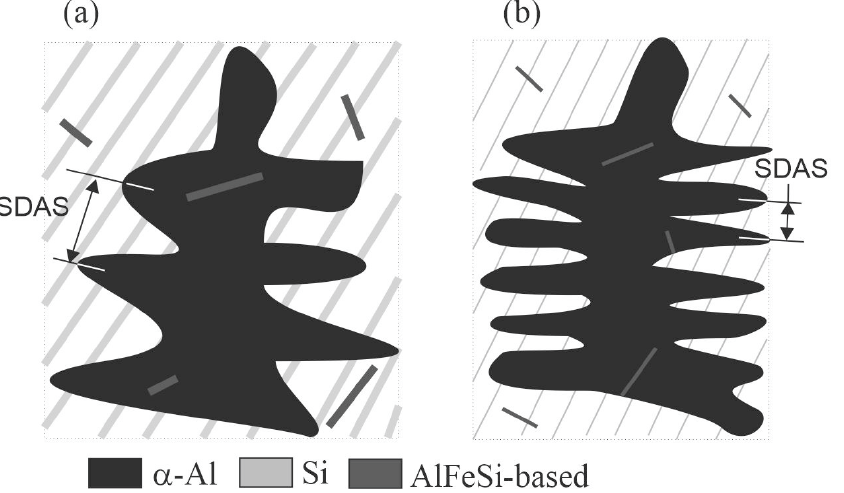
Figure 1. Schematic representation of the α -Al dendritic arrangements, Si and, IMCs for ( a ) slow and ( b ) fast solidified samples used in the present analysis.